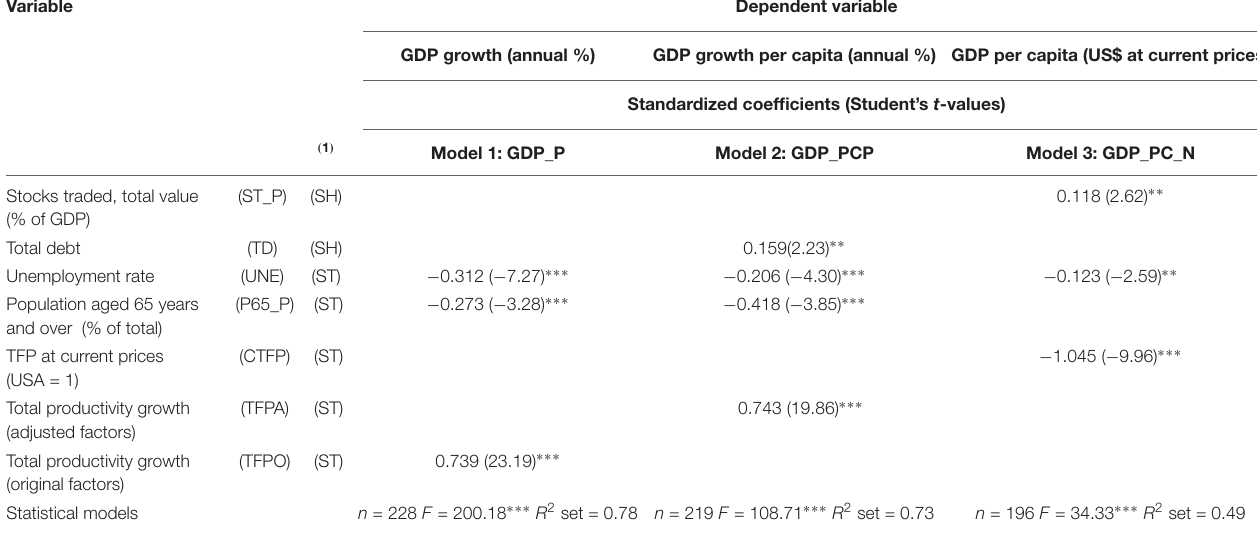
TABLE 5 | Regression results: estimation with panel data.